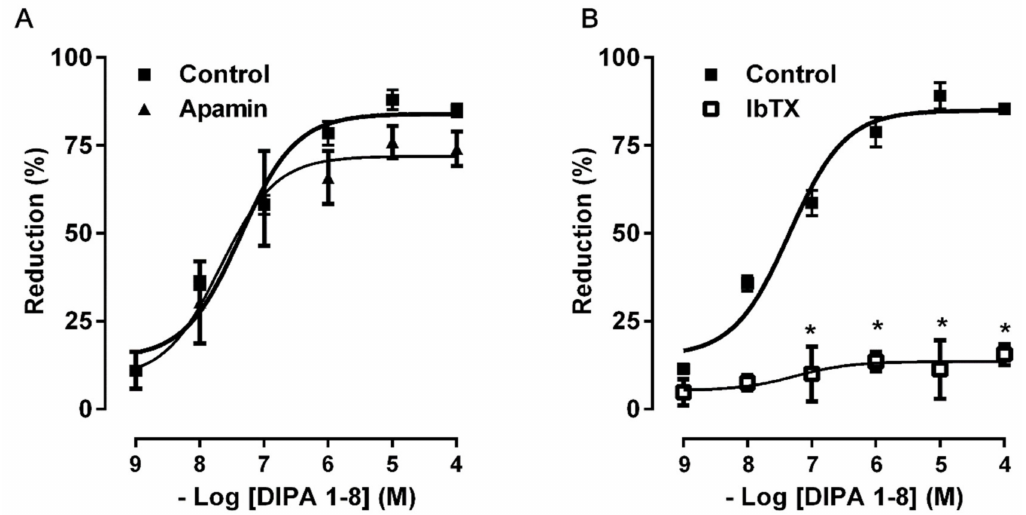
Figure 5. Concentration–response curves for the inhibitory e ff ects induced by DIPA 1–8 (1 nM–100 µ M) before and after apamin (100 nM) ( A ) and IbTX (10 µ M) ( B ). All values are means ± S.E.M ( n = 6) and are expressed as percentage of inhibition of the spontaneous contractions. * p < 0.05 compared with the respective control